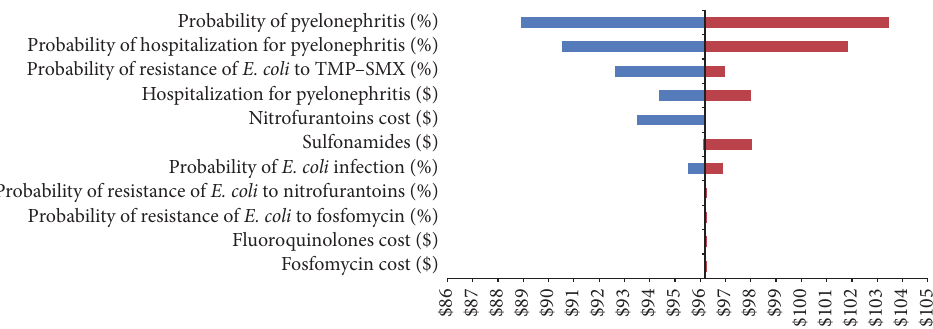
Figure 5: Tornado diagram comparing the results of the one-way sensitivity analyses of variables potentially affecting the expected value of the cost-per-patient (decision